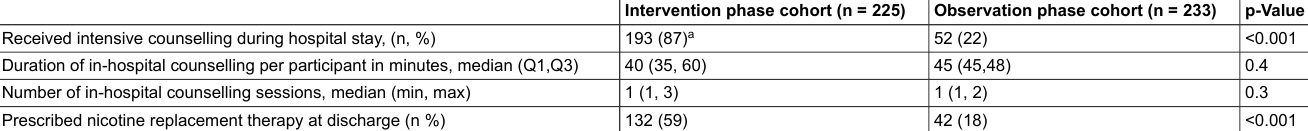
Table S2: Counselling received by the patients, by smoking cessation counselling phase (n = 558).